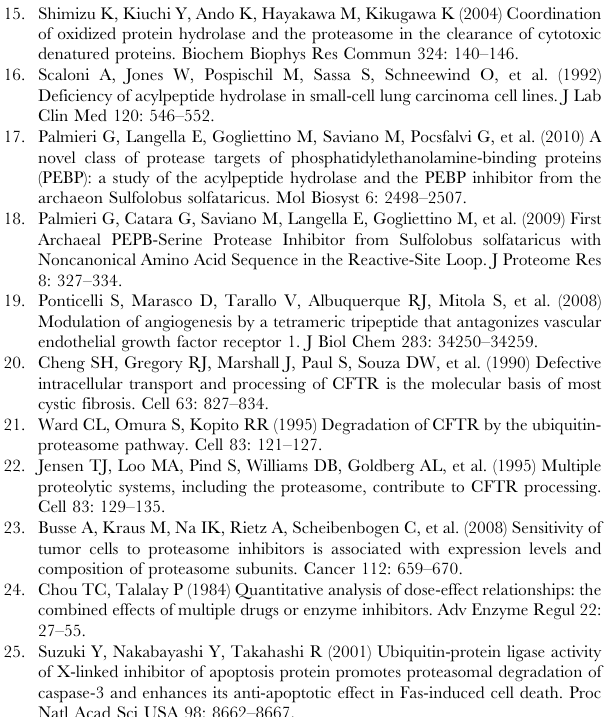
Figure S2 Far-UV CD spectra of the SsCEI peptides at different temperatures. Figure S3 Binding of increasing concentration of the SsCEI peptides (as indicated) to a-chymotrypsin. Figure S4 Gel filtration chromatography on a Superdex 200 column of protein extract from Caco-2 cells treated with 200 m M of SsCEI